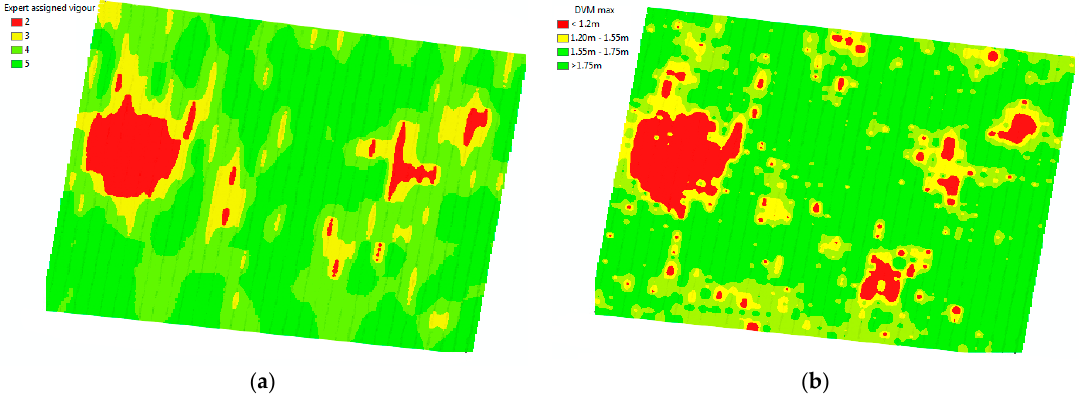
Figure 11. Expert-assigned classes of grapevines vigour per panel ( a ) and the results of a remotely- sensed vigour assessment of individual grapevines for February 2017 ( b ), site 2 with the V. vinifera Roussanne variety.